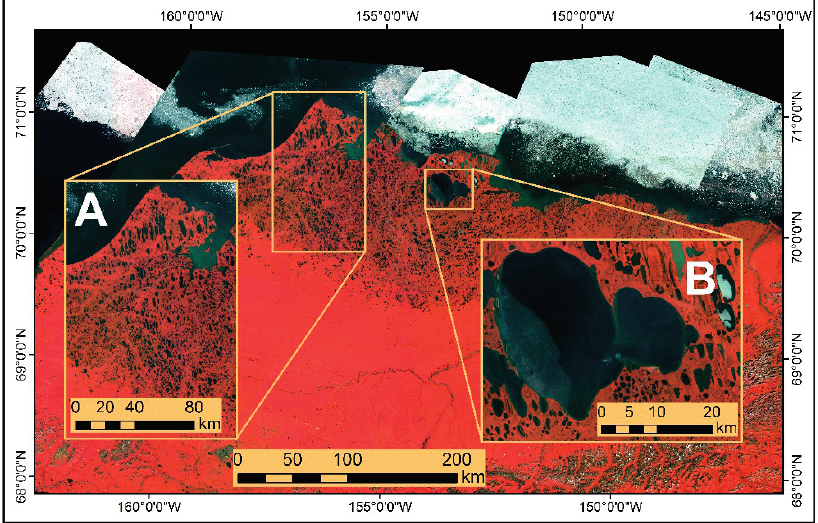
Figure 4. Landsat Multi-Spectral Scanner mosaic of the ACP showing the widespread distribution of oriented lakes with insets showing Barrow study area ( A ) and Teshekpuk Lake study area ( B ).